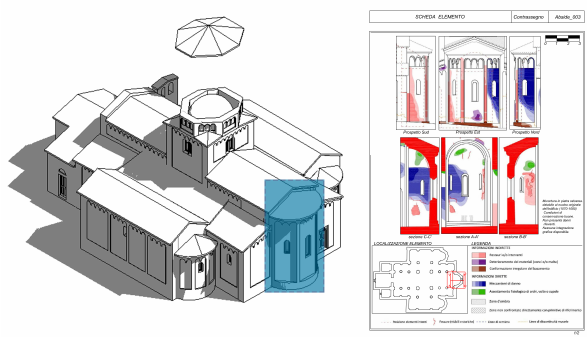
Figure 8. The data enrichment for an element. The linked file contains static analysis based on comparison between TLS point cloud and geometric primitives.